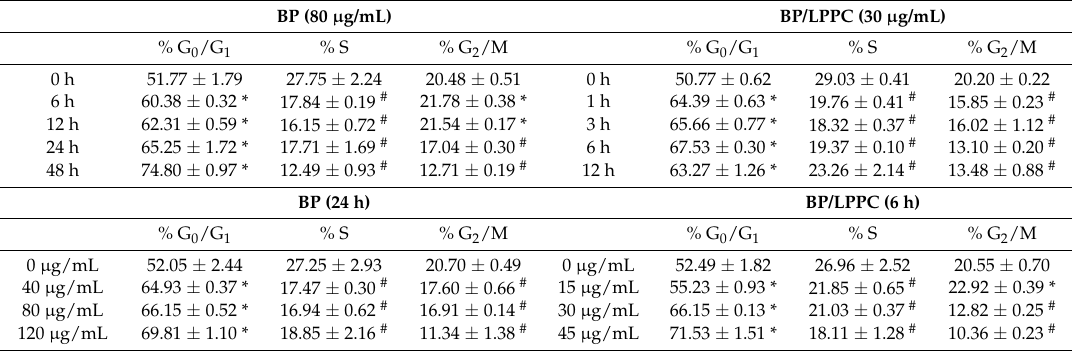
Table 2. The cell cycle distribution of BP- and BP/LPPC-treated cells.